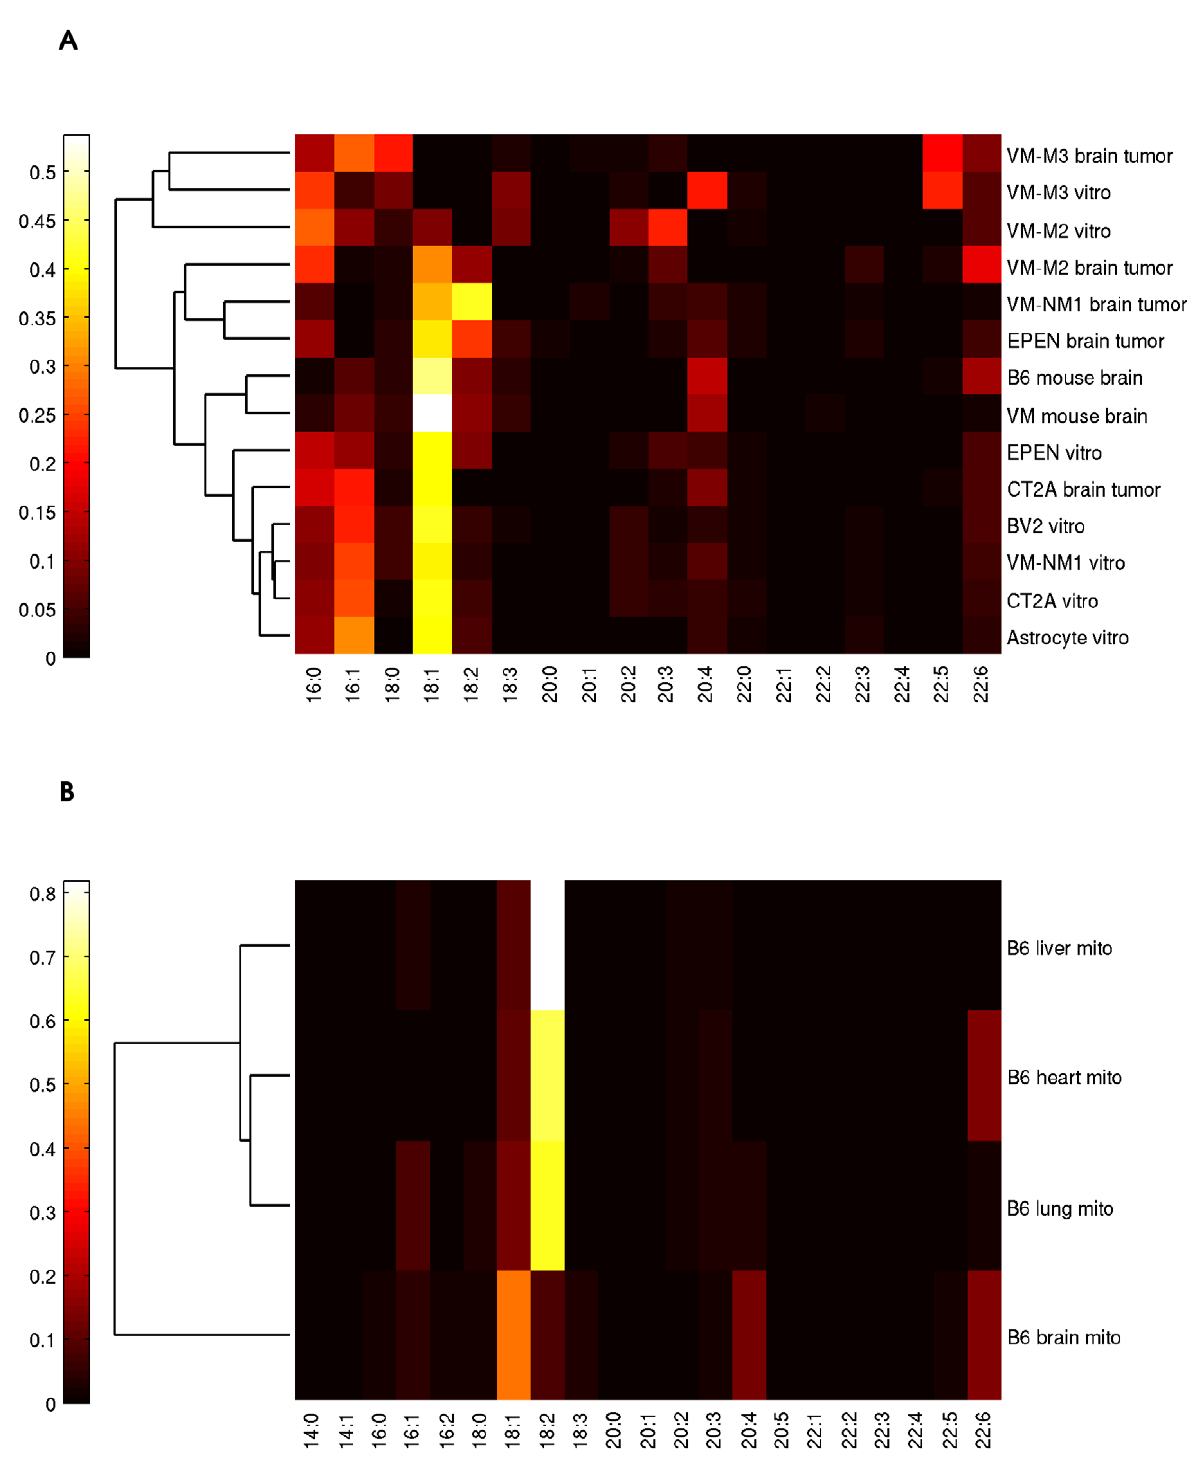
Figure 2. Comparison of CL FA compositions between 14 mouse brain samples (A) and 4 B6 mouse tissues (B). 18:1 is predominant in brain ( , 40%), while its percentage is reduced in some tumor samples (e.g. VM-M2 vitro , VM-M3 vivo VM-M3 vitro ). 18:2 is predominant in heart, lung, and liver ( , 70%).